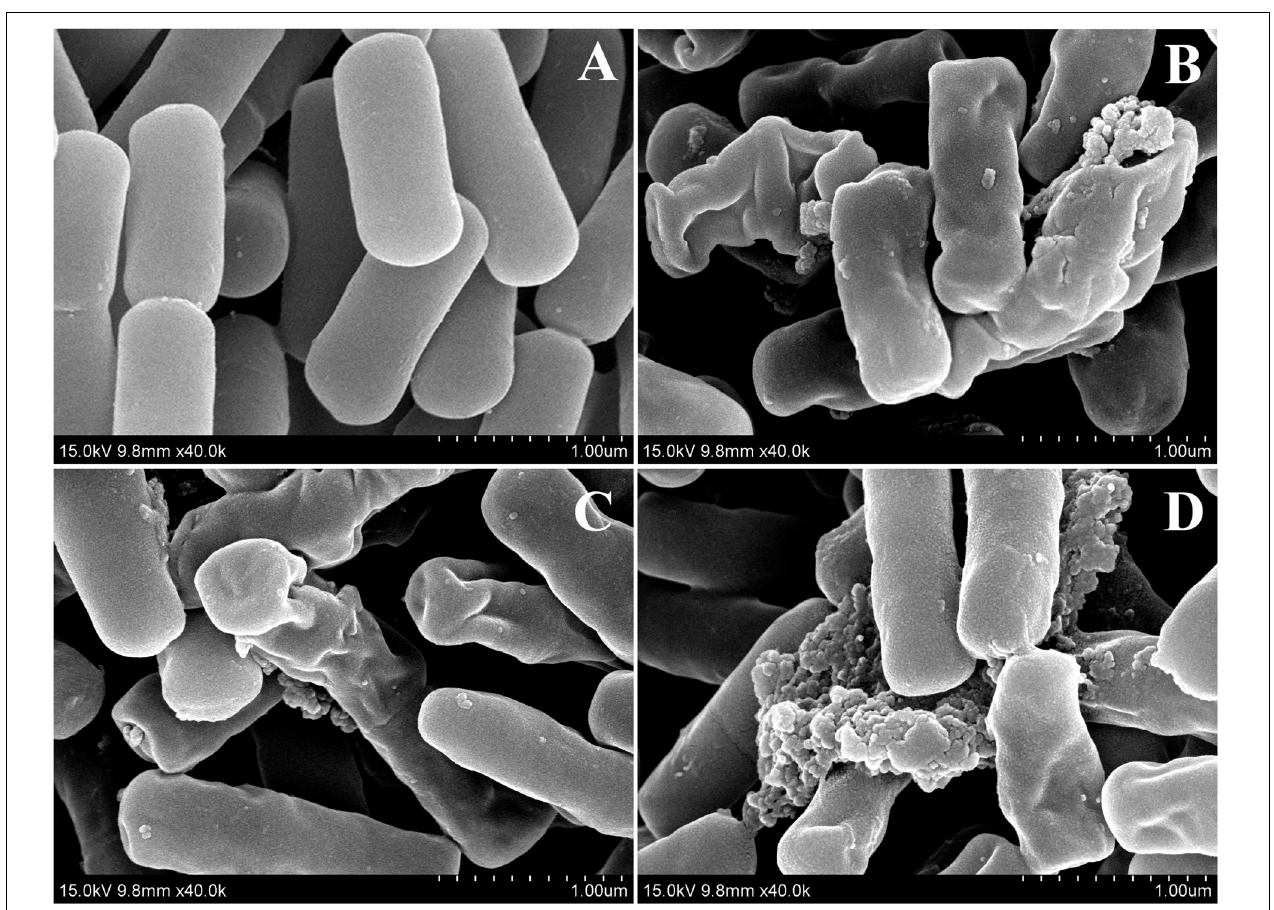
FIGURE 4 | SEM micrographs of E. coli ATCC 25922 treated by peptides at 1 × MICs. (A) Control, (B) dCATH for 60 min, (C) dCATH(1–16) for 60 min, and (D) dCATH(5–20) for 60 min. Control was processed without